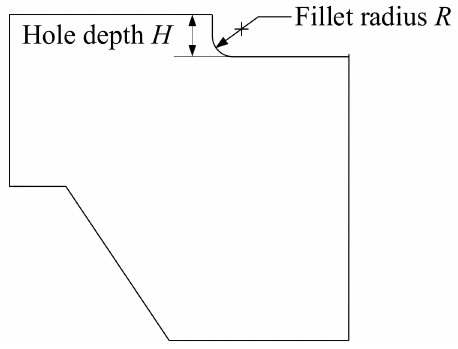
Figure 3. Schematic diagram of dimension